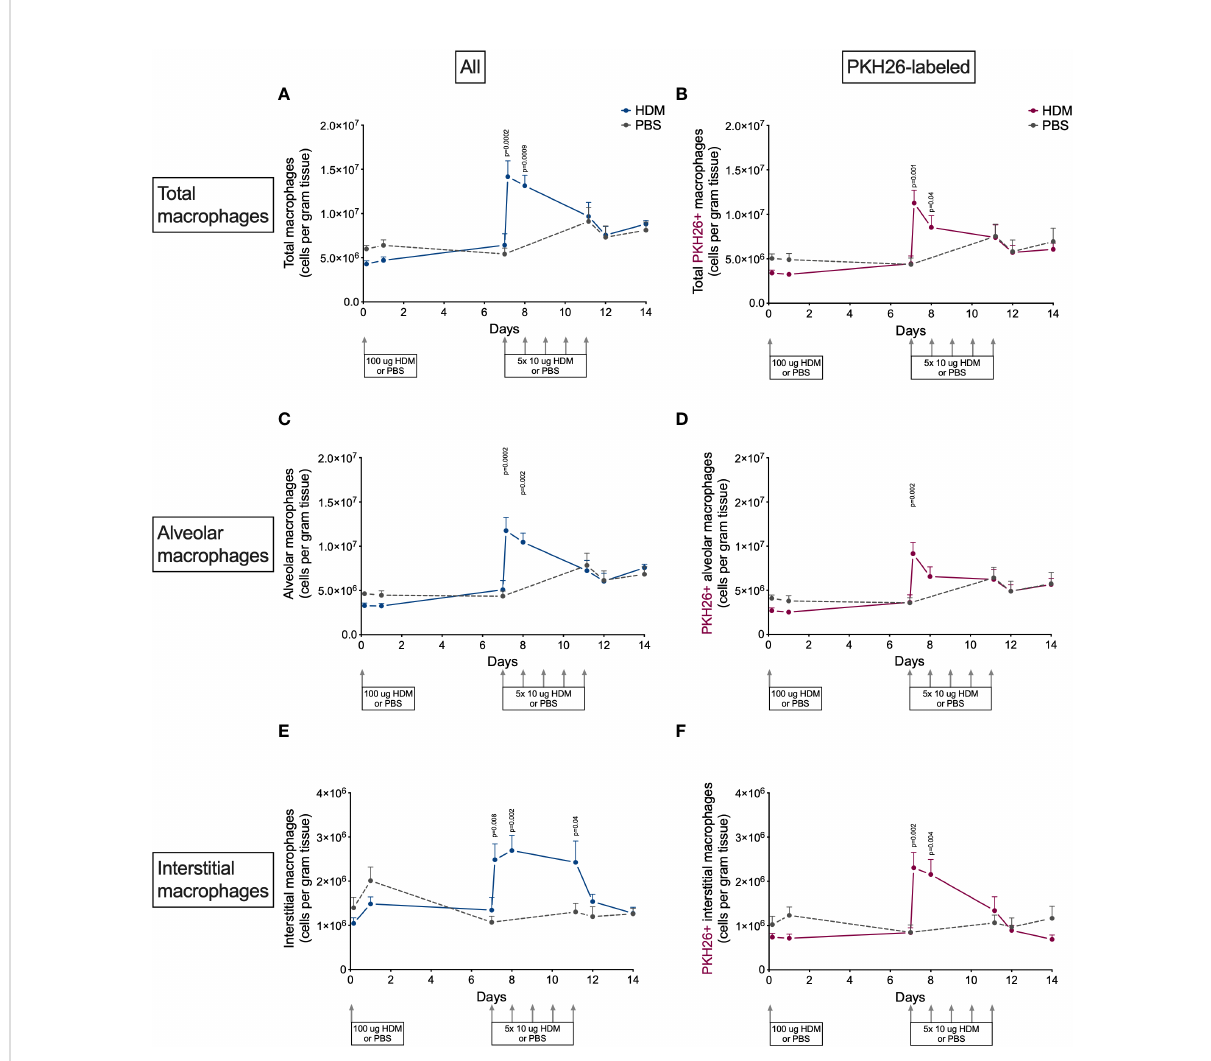
FIGURE 4 Numbers of (A) total macrophages, (B) PKH26+ total macrophages, (C) alveolar macrophages, D) PKH26+ alveolar macrophages, (E) interstitial macrophages, (F) PKH26+ interstitial macrophages in lung tissue of house dust mite (HDM)-exposed and phosphate-buffered saline (PBS)- exposed mice at different time points. The differences between HDM and PBS per time point were tested using a Student ’ s t test. Day 7.2 and day 8 of HDM were compared to day 7 of PBS with a one-way ANOVA with Sidak ’ s correction for multiple testing because these mice did not have matching PBS-exposed mice. P<0.05 was considered signi fi cant. Per time point the geometric mean and standard error of the mean per group are shown (4 males and 4 females per group, except for PBS 14 days that had 3 males and 4